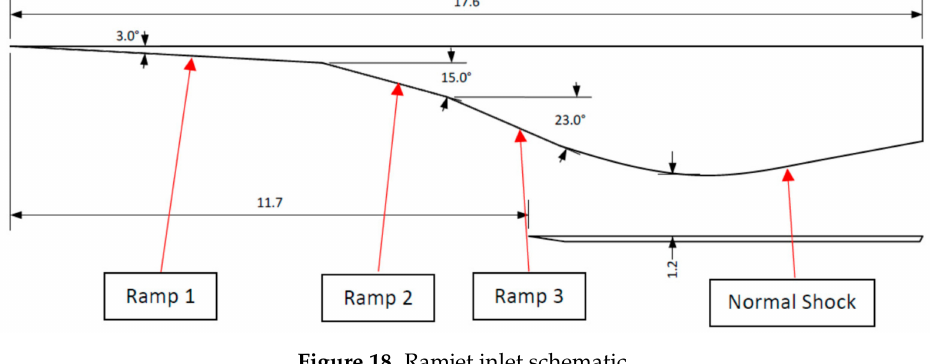
Figure 18. Ramjet inlet schematic.